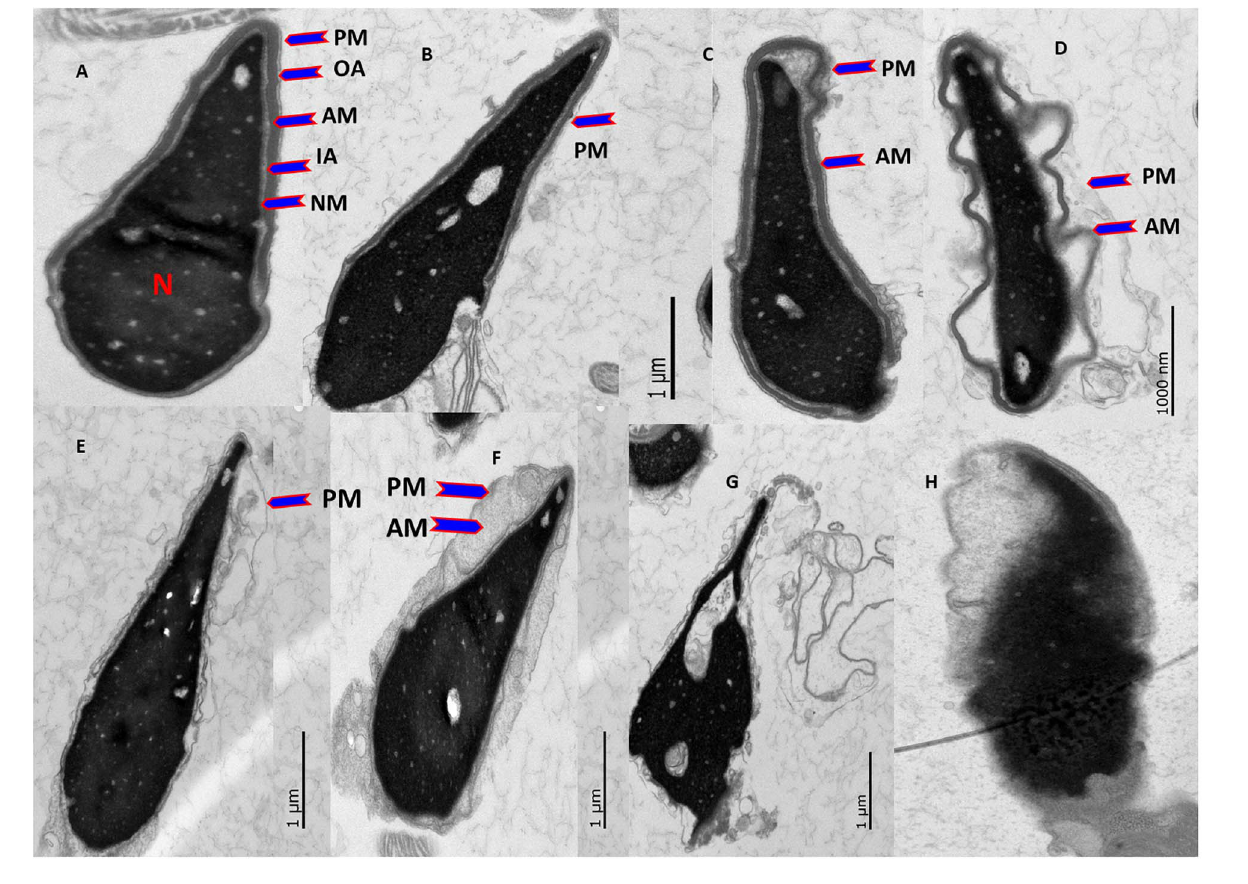
FIGURE 3 | Effect of vitrification on the ultrastructure of spermatozoa heads. TEM images of spermatozoa heads. (A) Spermatozoa with undamaged normal heads. From outward in : plasma membrane ( PM ), outer acrosomal ( OA ) membrane, acrosomal material ( AM ), inner acrosomal ( IA ) membrane, nuclear membrane ( NM ), and nucleus ( N ). (B) Spermatozoa like in (A) , except that the PM was damaged. (C) Spermatozoa with swollen PM and acrosome. (D) Spermatozoa with swollen and wavy PM and acrosome. (E) Damaged OA and IA membranes and leaked out AM. (F) Damaged OA and IA membranes and condensed AM. (G) Detached acrosome and PM, i.e., spermatozoa without a cap. (H) Nude spermatozoa: absent IA membrane and damaged